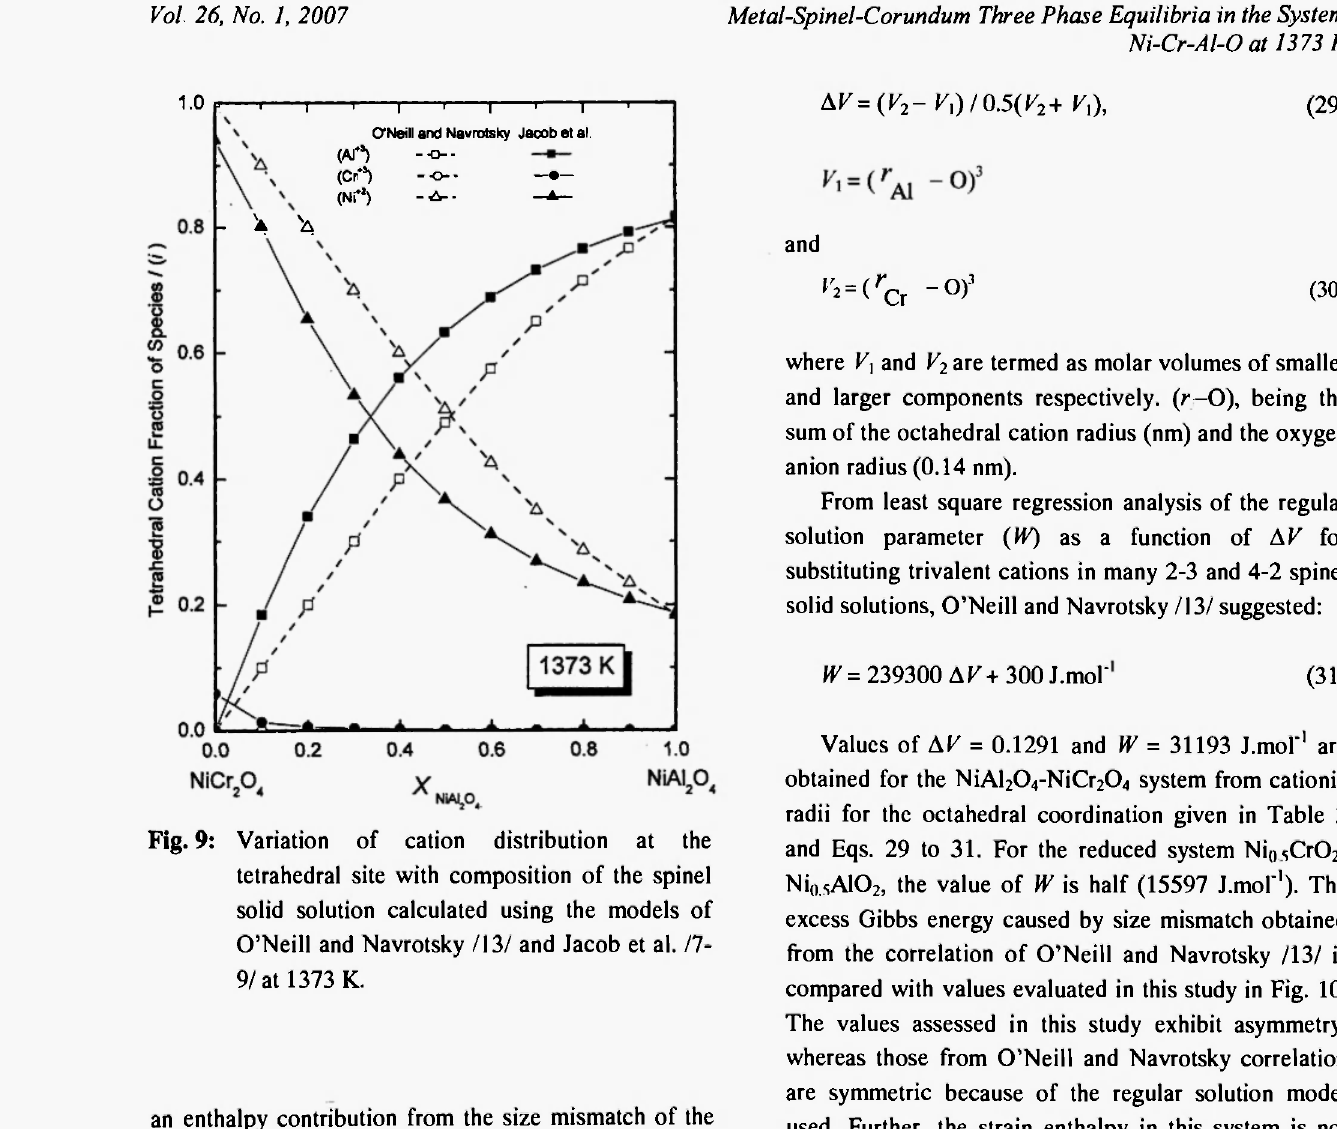
Fig. 9: Variation of cation distribution at the tetrahedral site with composition of the spinel solid solution calculated using the models of O'Neill and Navrotsky /13/ and Jacob et al. Π- 9/ at 1373